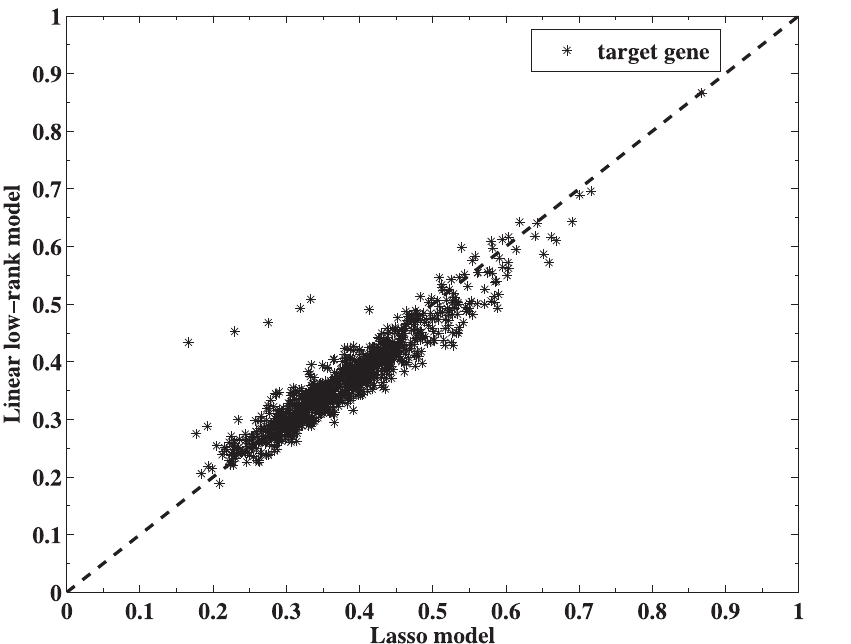
Figure 2. Comparison of the testing performance of the linear low-rank regularization model vs. Lasso on the human hematopoietic gene expression dataset. Each * indicates one target gene. X-axis represents the test RMSE of the Lasso model, whereas Y-axis represents the test RMSE of the linear low-rank model. The figure shows that the low-rank model yields lower testing error than Lasso for most target genes.